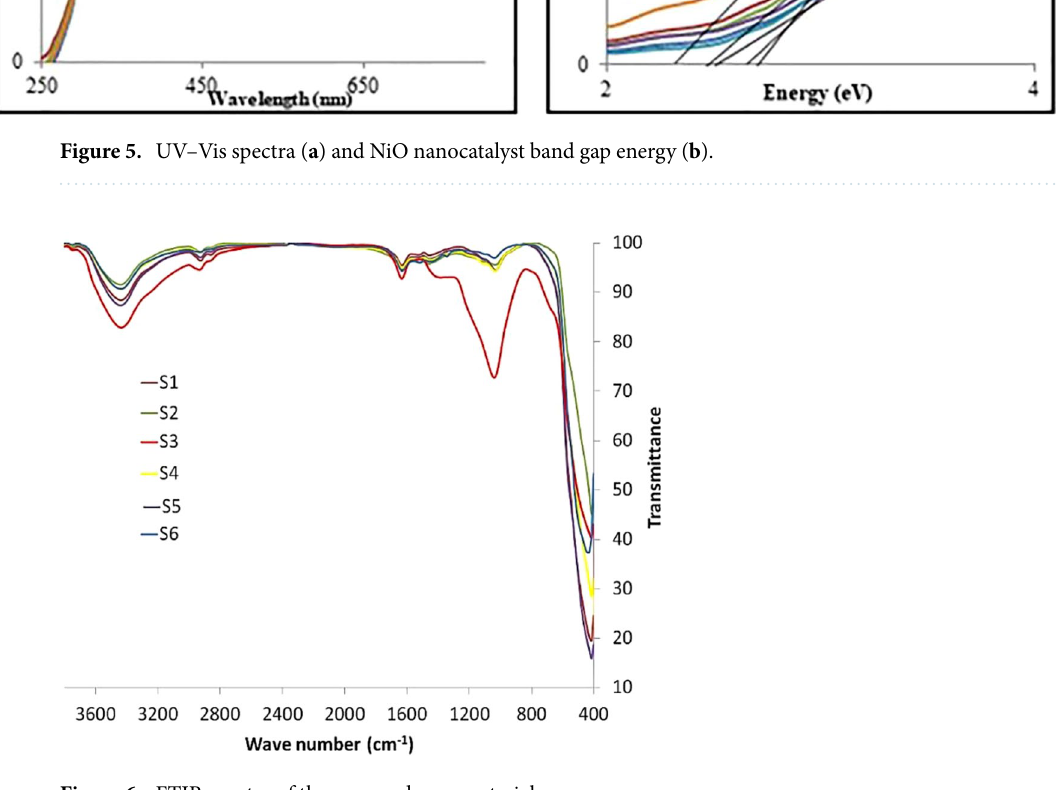
Figure 6. FTIR spectra of the prepared